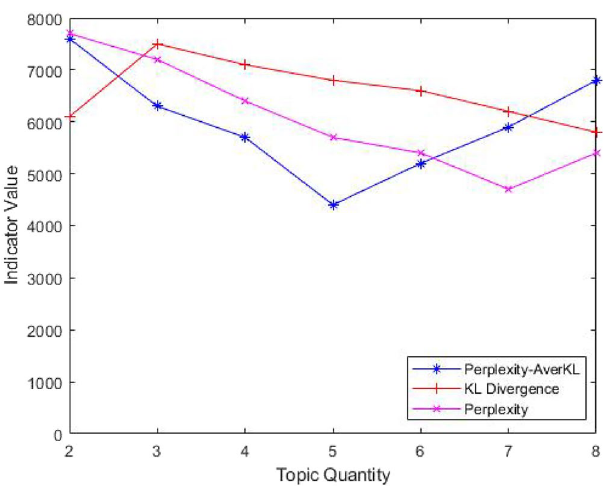
Figure 7. The efficacy comparison among Perplexity-AverKL, Perplexity and KL